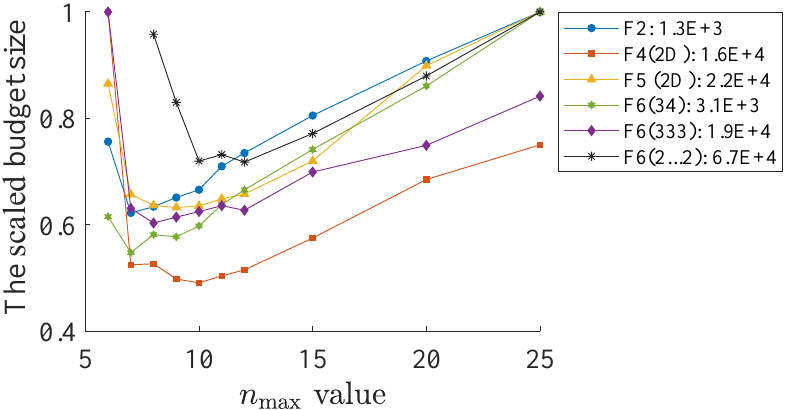
Figure 5. The scaled average budget size required to obtain all global optima in different problems with varying n max value. A total of 100 replications are